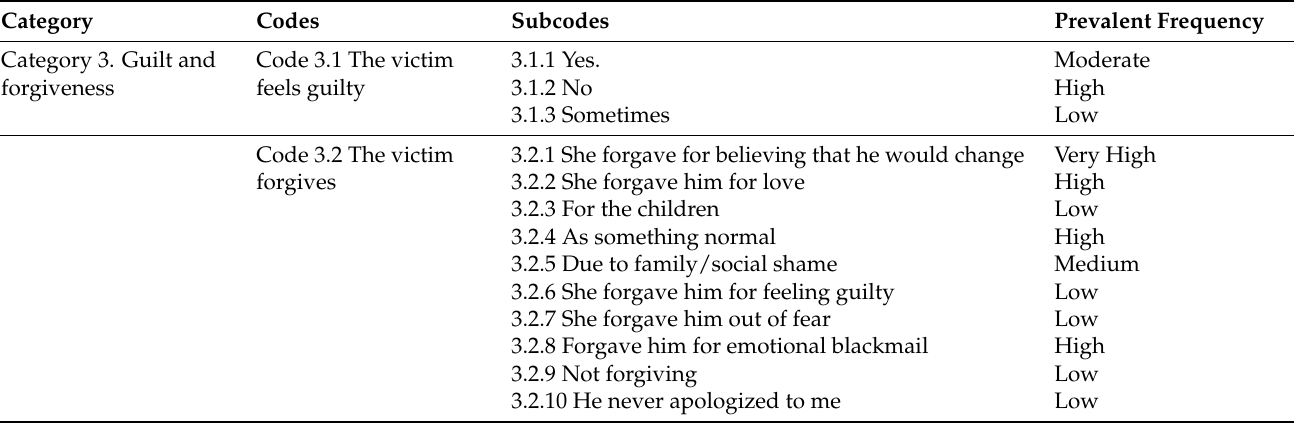
Table 3. Category